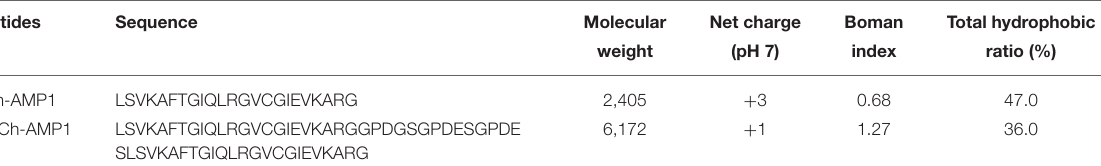
TABLE 1 | Physicochemical properties of MCh-AMP1 and DiMCh-AMP1 are shown. Peptides